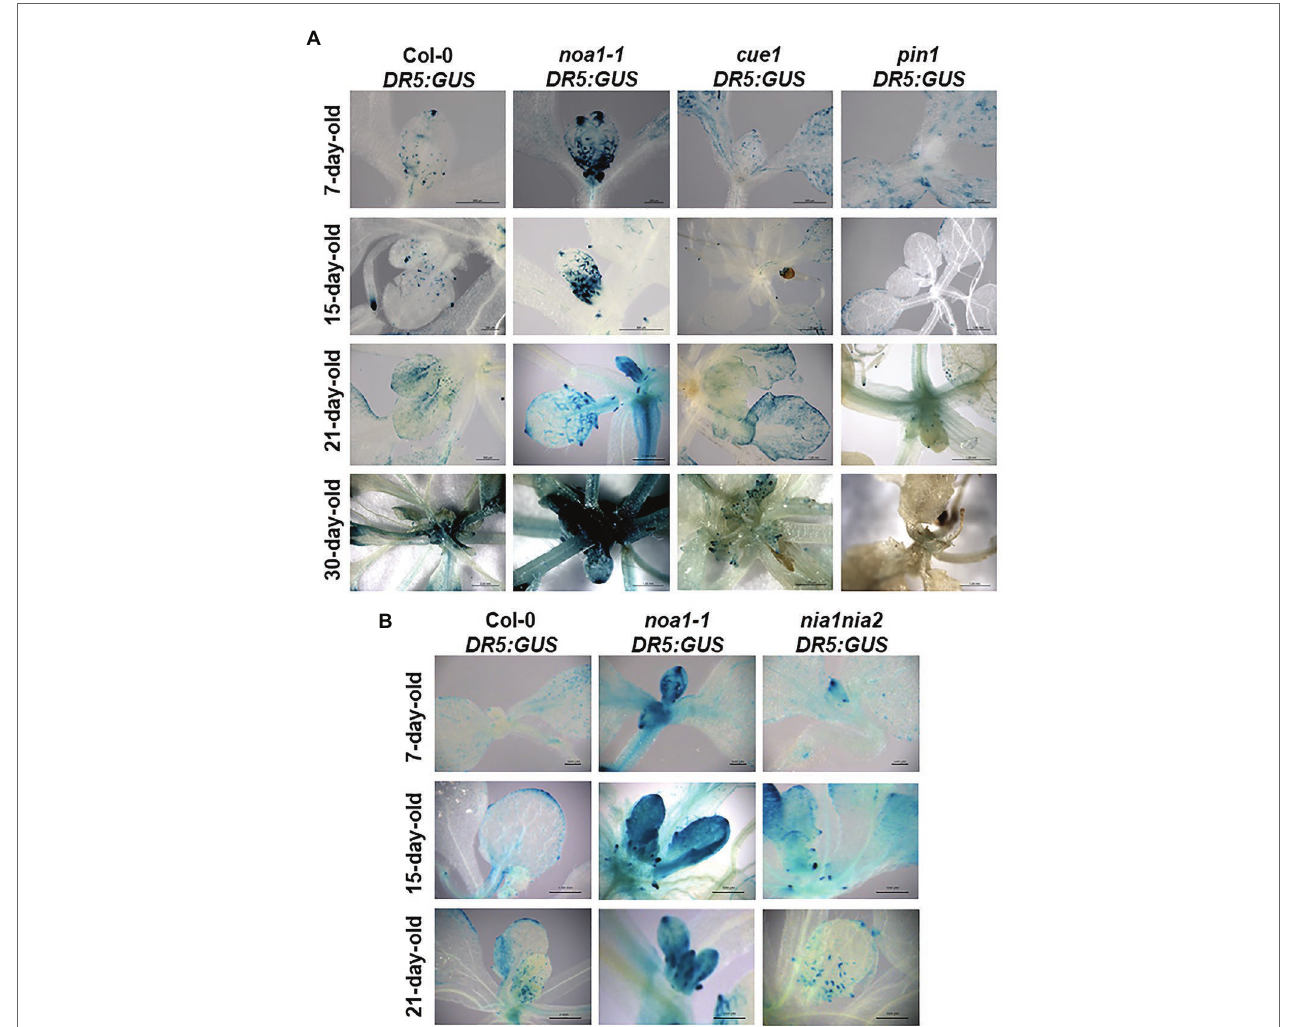
FIGURE 5 | Auxin response is impacted by mutations in NOA1 and CUE1 . Pattern of DR5:GUS expression in transformed A. thaliana Col-0 and noa1-1 , cue1-1 , and pin1 mutant lines, showing histochemical localization of ß-GUS activity during morphogenesis in first and second leaves of 7-day-old seedlings, sixth and seventh leaves of 15-day-old seedlings, leaves of 21-day-old plants, and 30-day-old plants (A) . Scale bars, between 200 and 1,000 μ m. Histochemical localization was also showed in nia1nia2 NO deficient mutant in 7-, 15-, and 21-day-old plants (B) . At least, 10 seedlings and plants per genotype were analyzed all showing a similar expression pattern and a representative image was